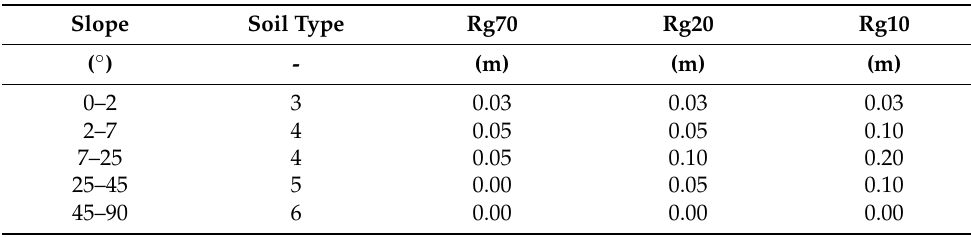
Table 4. Damping parameters based on slope thresholds used for the alpine slope near La Verda– Rougemont in